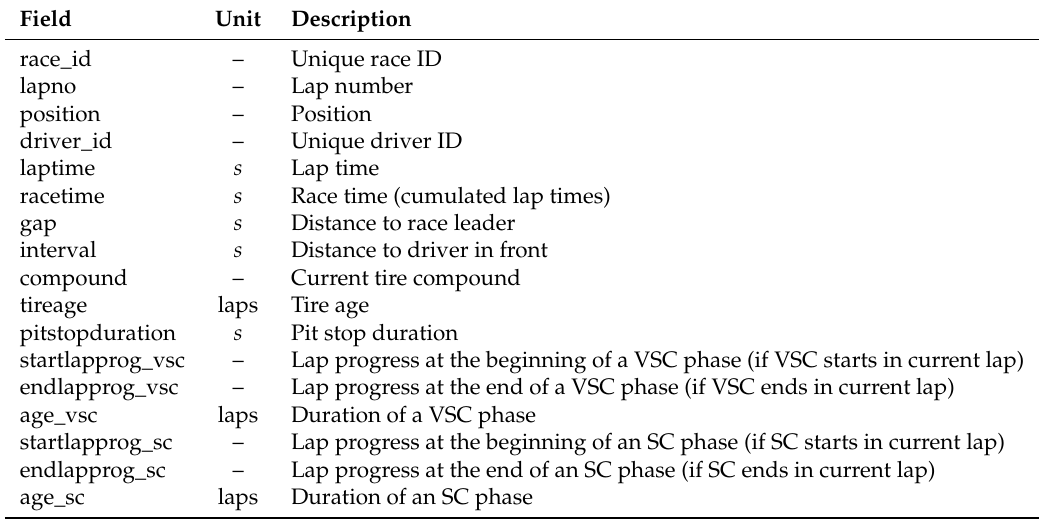
Table 1. Relevant entries in the laps table of the database. All content refers to the end of the respective lap.